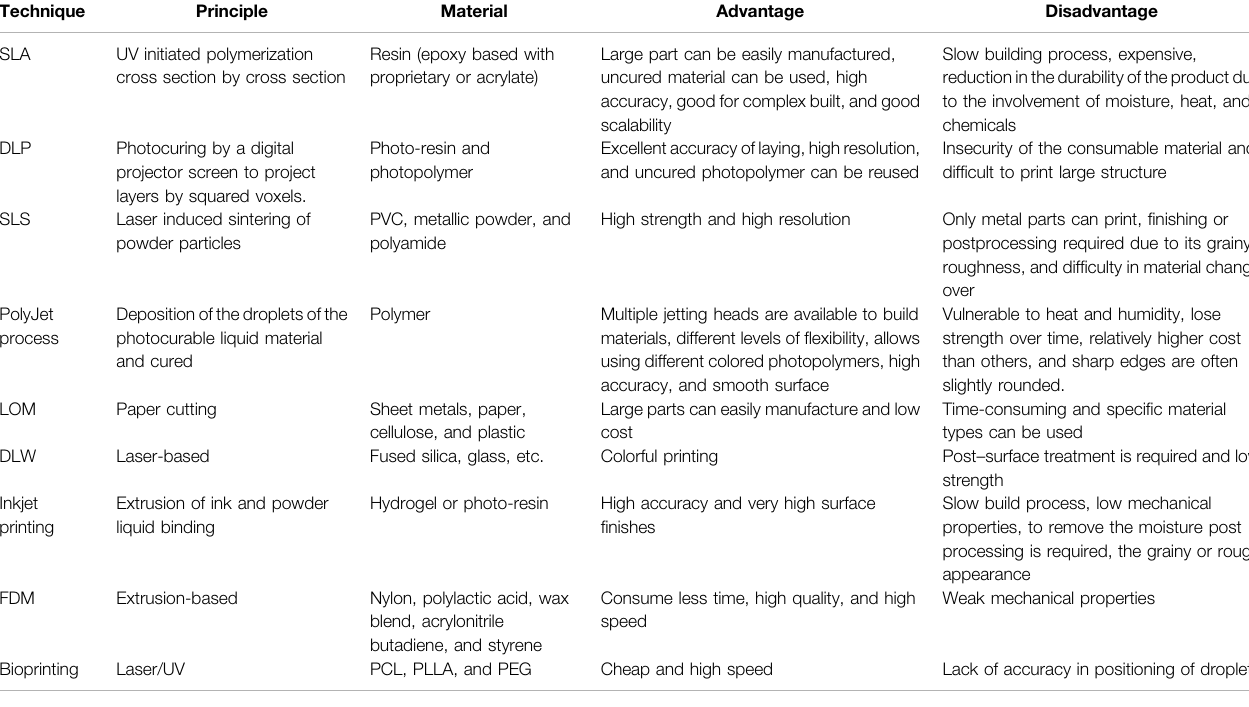
TABLE 1 | Comparative analysis of various 3D printing methods with a special focus on materials used, their bene fi ts, and drawbacks.